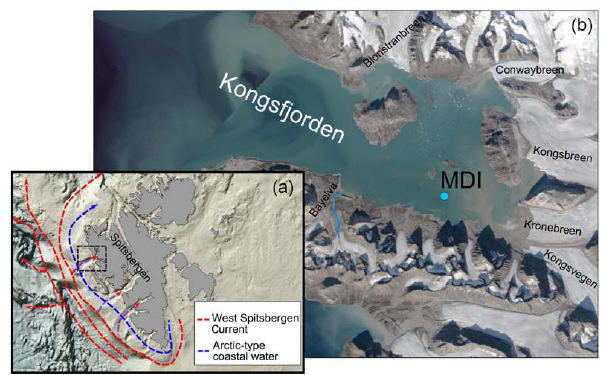
Figure 1. (a) Map of Svalbard with a simplified scheme of the main current circulation along the western Spitsbergen region. The light blue line shows the Arctic-type coastal water and the northward red arrow represents the warm West Spitsbergen Current (WSC). (b) Map of Kongsfjorden (area of study). The cyan point shows the Mooring Dirigibile Italia (MDI) site. MDI is located at 100m of water depth, at the distance of 1.7km from the southern coast, be- tween the Kronebreen front (7km far) and the sill. Positions of the Bayelva River and of the main glacier fronts are also